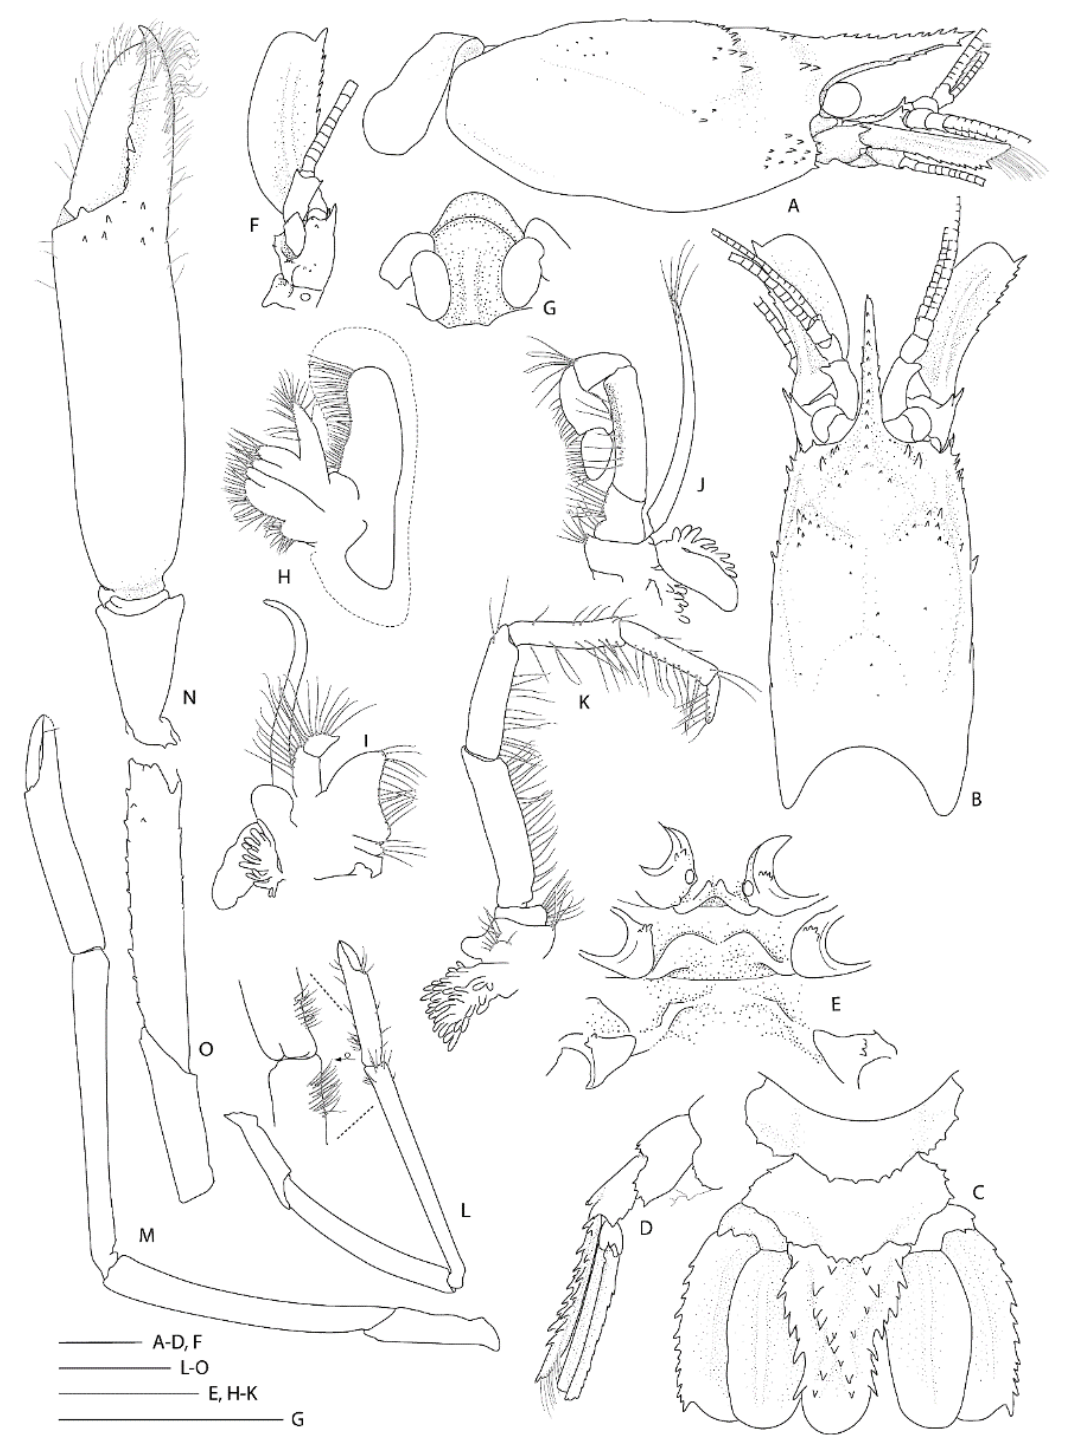
Figure 20. Spongiocaris antipodes sp. nov., paratype F (NIWA 127133). ( A ) Carapace and first pleonite, lateral. ( B ) Carapace and cephalic appendages, dorsal. ( C ) Pleonites 5–6, urosome and telson, dorsal. ( D ) Pleonites 5–6, urosome and telson, lateral. ( E ) Thoracic sternites 6–8 with coxae of pereiopods, ventral. ( F ) Left antenna, ventral. ( G ) Epistome, labrum partially covered by mandibular palps, ventral. ( H ) Left maxilla. ( I ) Left Mxp1. ( J ) Left Mxp2. ( K ) Right Mxp3. ( L ) Left P1 with detail of merocarpal setiferous organ. ( M ) Right P2. ( N ) Right P3 distal portion, lateral. ( O ) Right P3 proximal portion, lateral. Scale bars = 2 mm.